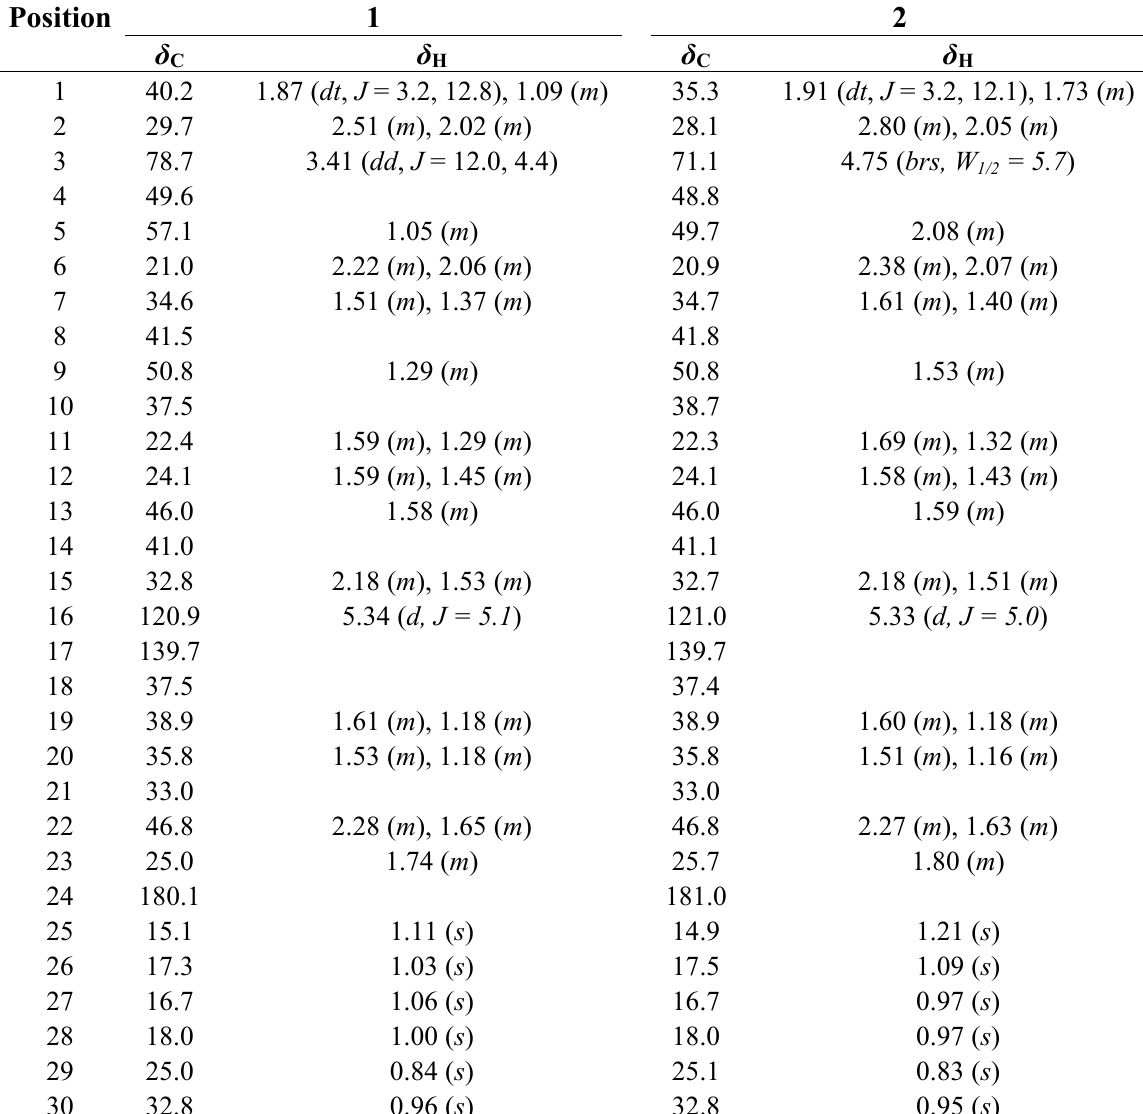
Table 1. 1 H-NMR (400 MHz) and 13 C-NMR (100 MHz) Spectral Data of Compounds 1 and 2 in C D N ( δ in ppm, J in Hz). 5 5